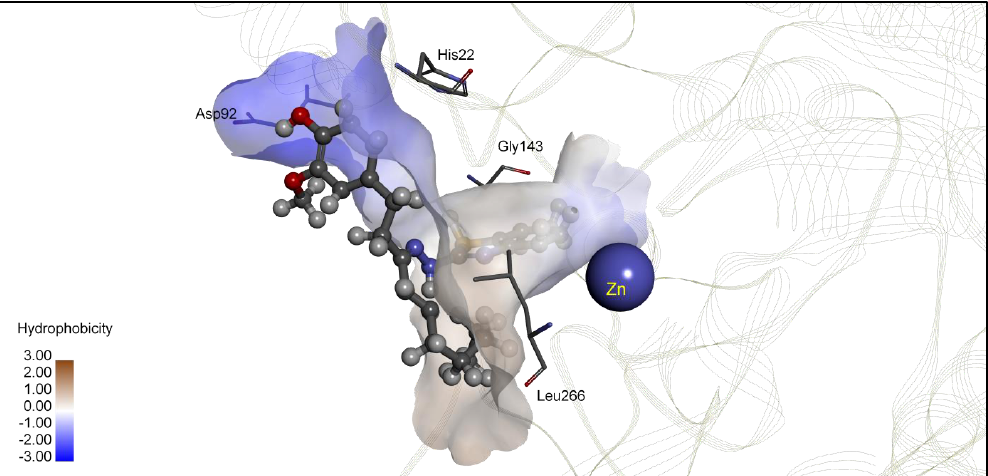
Figure 3. The interaction modes 4d in the active site of HDAC3.